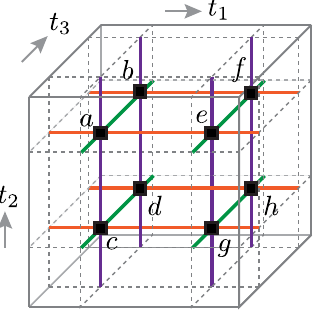
FIG. 12. Projection of the membrane process time sequence in Fig. 11 to three-dimensional space at t ¼ − ∞ . Lines show the pairwise intersections of projected worldsheets. Purple lines, F and G worldsheets; orange lines, F and H ; green lines, G and H . Although there are eight triple points here, the triple linking is still the same as for the three-flux-loop braiding process, Fig. 13. The directions t 1 show the time ordering of contributions ; 2 ; 3 to projection from worldsheets G , H , F , and so clarify to which Tlk some triple point contributes [see after Eq. (33)]. IJK